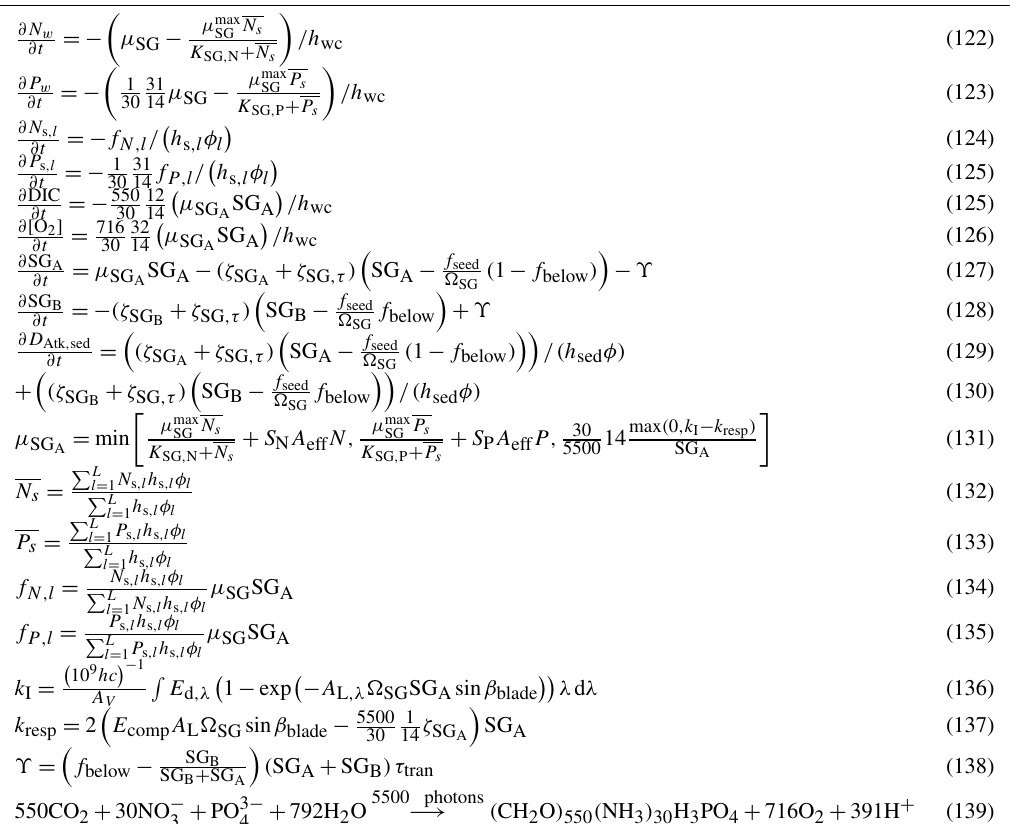
Table 22. Equations for the seagrass model. Other constants and parameters are defined in Table 23. The equation for organic matter formation gives the stoichiometric constants; 14gNmolN − 1 ; 12gCmolC − 1 ; 31gPmolP − 1 ; 32gOmolO 2 − 1